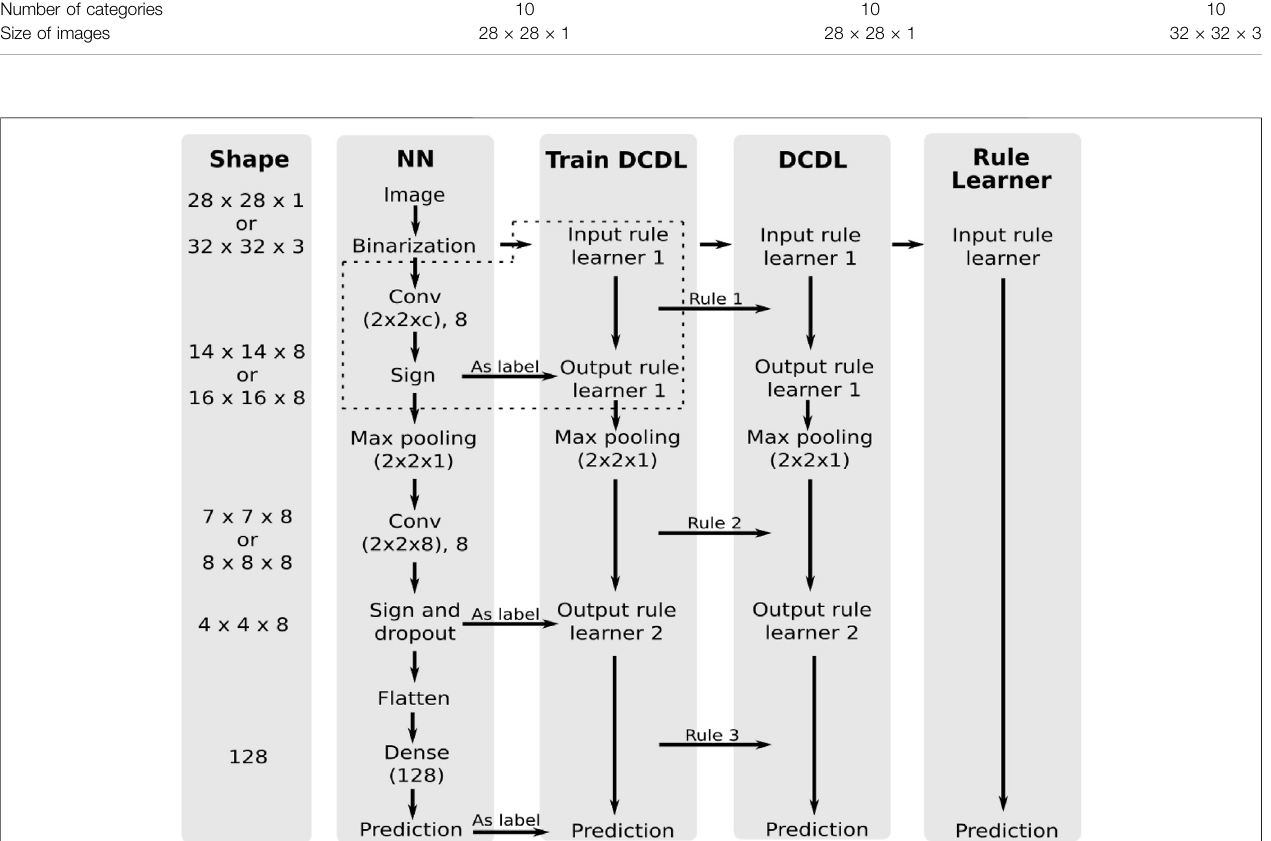
FIGURE2| Experimentalsetupforcomparingtheneuralnetwork,theDCDLwitharulelearnerandthevanillarulelearnerapproach. c dependsonthedatasetand is the number of color channels. The content of the dotted box is shown in more detail in Figure 3 .